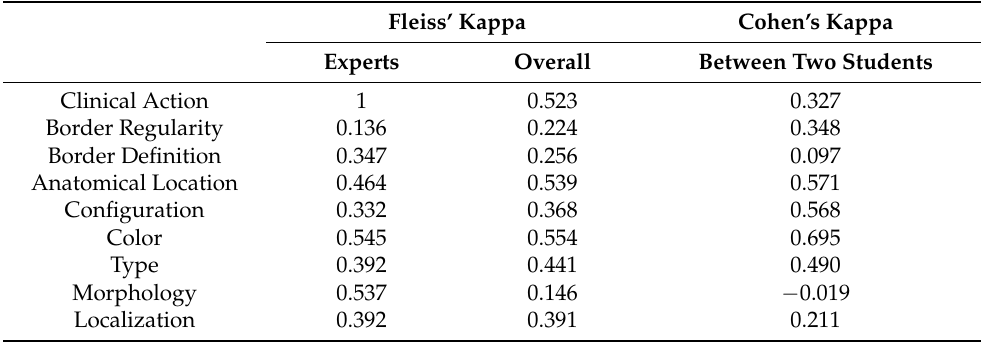
Table 2. Fleiss’ and Cohen’s Kappa evaluating the classification agreement of 20 oral lesion images by three experts and two students. Fleiss’ Kappa Cohen’s